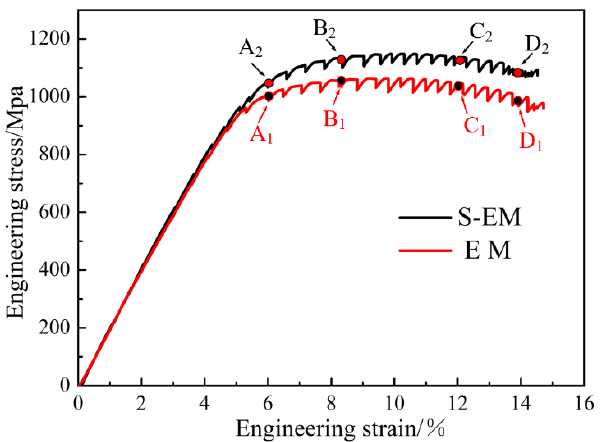
Figure 6. Engineering stress–strain curves for the EM and S-EM after the in situ SEM tensile test. The letters A 1 (A 2 ), B 1 (B 2 ), C 1 (C 2 ), and D 1 (D 2 ) indicate the points at which the test was interrupted for imaging.